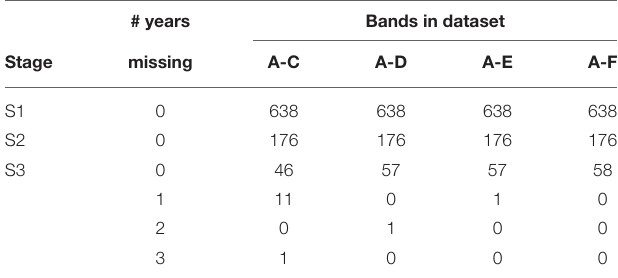
TABLE 10 | MET dataset construction for 2019 selection decisions in chickpea breeding